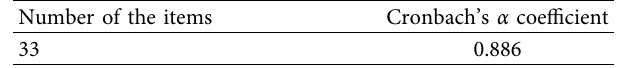
Table 2: The reliability of the